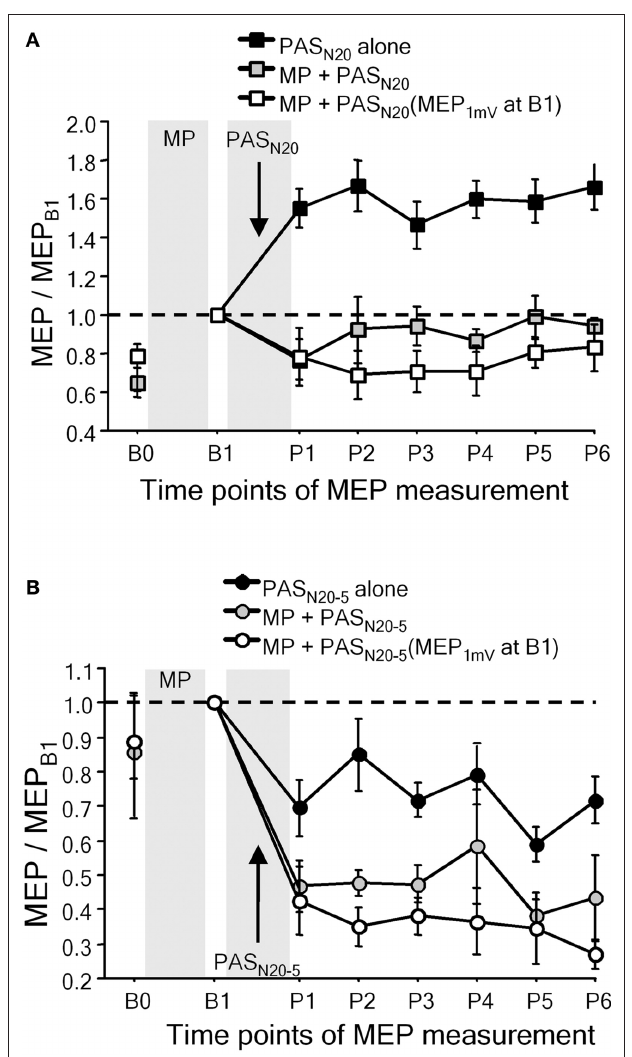
Figure 4 | Motor learning involves LTP-like mechanisms in human primary motor cortex. (A) Interactions between motor practice (MP) and timing dependent LTP-like plasticity induced by PAS . The PAS -induced N20 N20 long-lasting MEP increase (PAS alone, filled square) was completely N20 suppressed by MP associated motor learning immediately prior to PAS (gray squares). White squares refer to a control experiment in which any increase in MEP amplitude induced by MP was adjusted for by a reduction in TMS intensity (reinstallation of baseline MEP amplitude (MEP ) at time point B1) 1mV (adapted, with permission, from Figure 4, Ziemann et al., 2004). (B) Interactions between MP and timing dependent LTD-like plasticity induced by PAS . Note that motor learning enhanced the lasting decrease in MEP N20 − 5 amplitude induced by PAS alone (adapted, with permission, from Figure N20 − 5 5, Ziemann et al.,